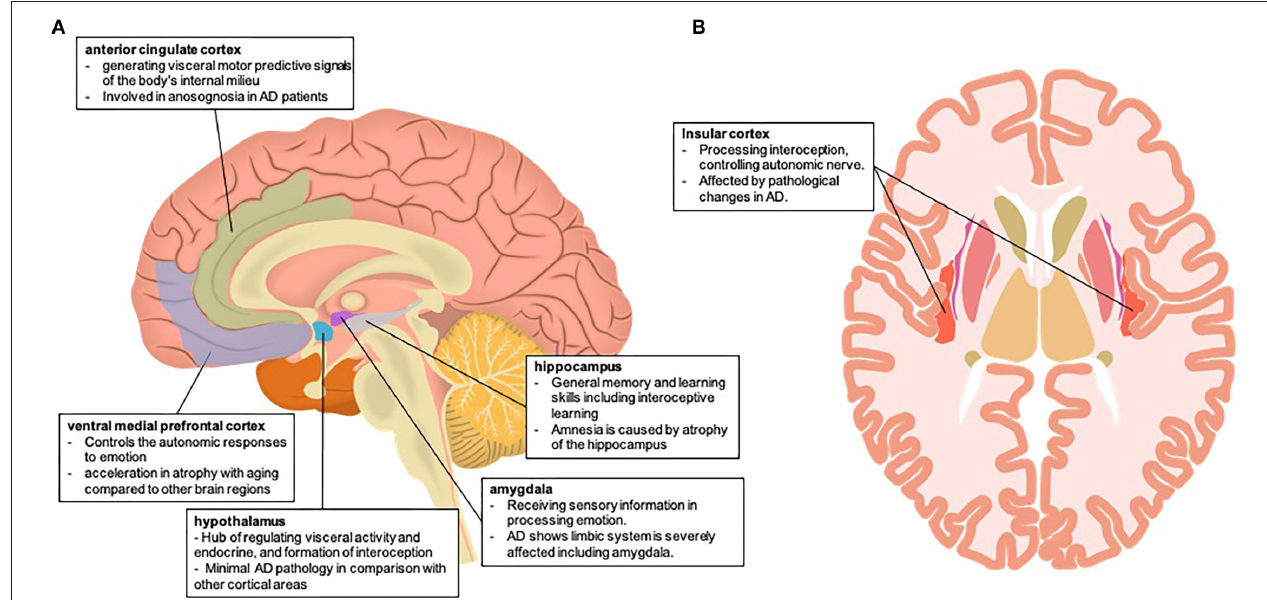
FIGURE 1 | Brain neural mechanism of impaired interoception in Alzheimer’s disease (A) involving the brain area of interoception and the autonomic nervous system in the mid-sagittal section (B) involving the brain area of interoception and the autonomic nervous system in the horizontal section. Both brain illustrations were used and modified from the following site: (A) Database Center for Life Science (DBCLS), mid-sagittal plane of the brain, February 1, 2021, doi: 10.7875/togopic.2021.023; (B) Database Center for Life Science (DBCLS), Horizontal plane of the brain, February 1, 2021, doi: